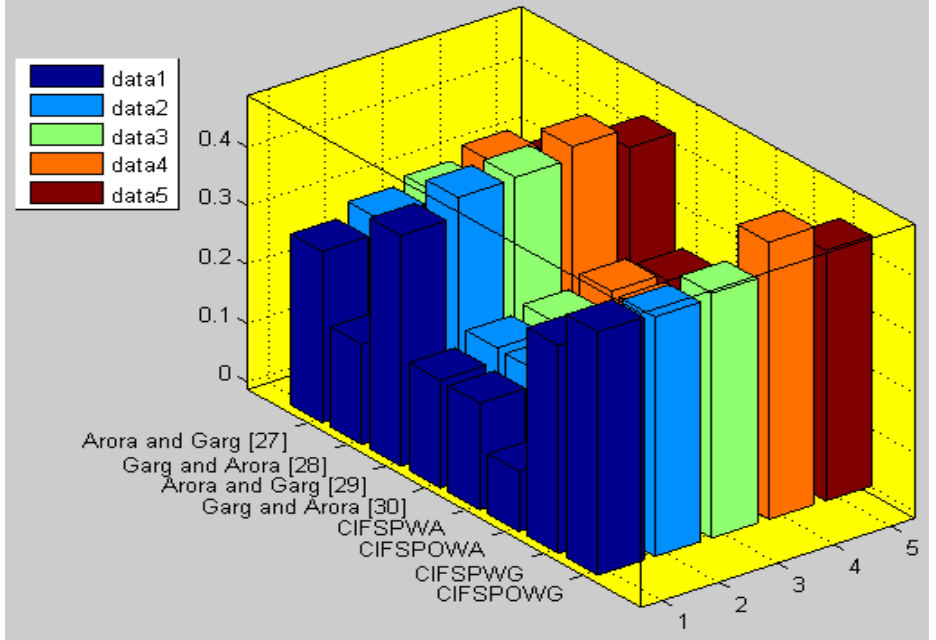
Figure 5. Graphical expressions of the information in Table 13. Table 13. Comparative analysis of the existing and elaborated operators. Methods Score Values Ranking Values